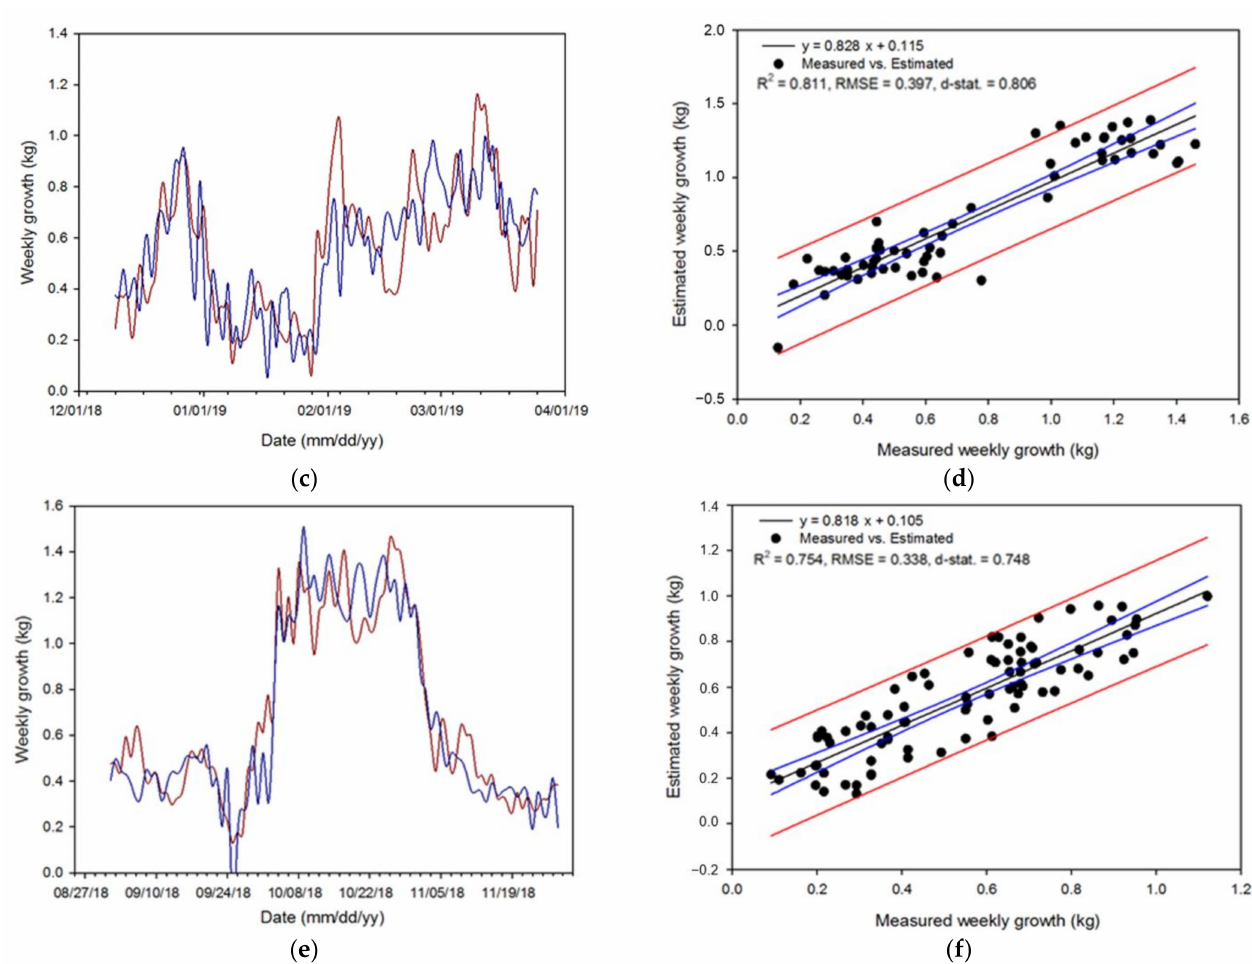
Figure 5. Comparison of the weekly crop growth rate measured by the fresh weight measuring system and estimated by the recurrent neural network (RNN) algorithm during growth period 1 (1 February 2018–1 June 2018) ( a , b ); growth period 2 (1 December 2018–1 April 2019) ( c , d ); and growth period 3 (1 September 2018–1 December 2018) ( e , f